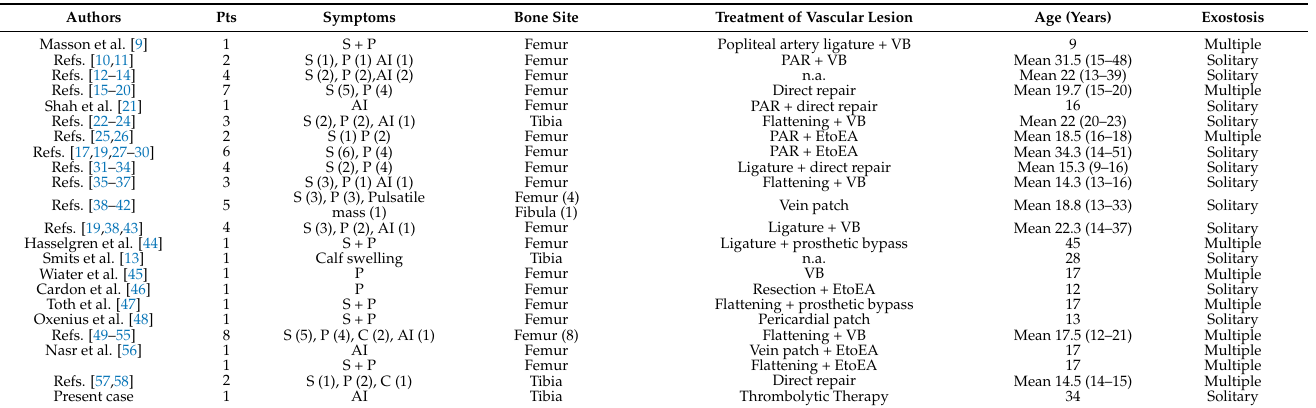
Table 1. Summary of the published reports on osteochondroma presenting with lower extremity vascular symptoms and